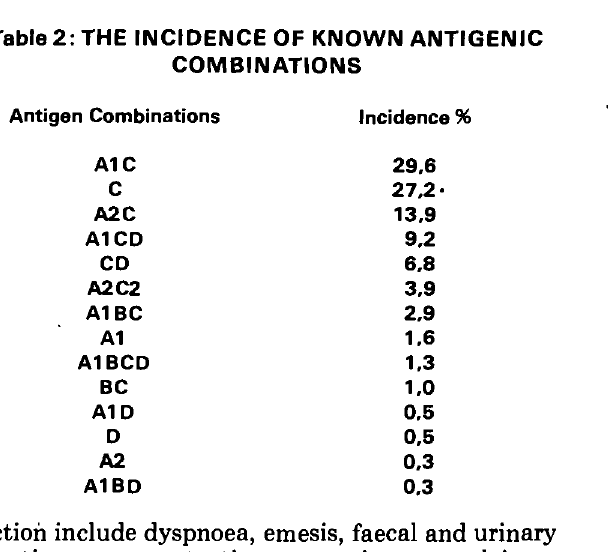
Table 2: THE INCIDENCE OF KNOWN ANTIGENIC COMBINATIONS